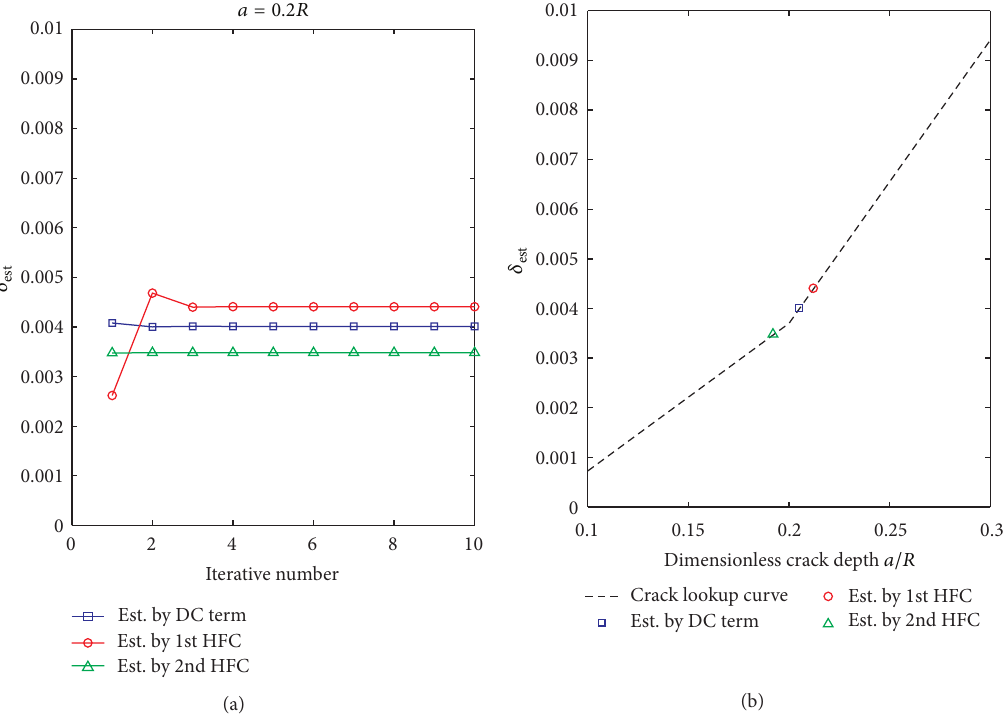
Figure 8: Damage parameter estimation for crack 𝑎 = 0.2𝑅 : (a) damage estimates iteration; (b) correlation between damage estimates and crack depth.